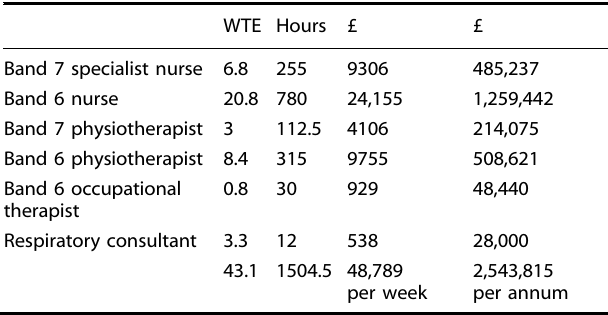
Table 3. Projected costs of staf fi ng the CRRT based on staf fi ng levels required during the month of May